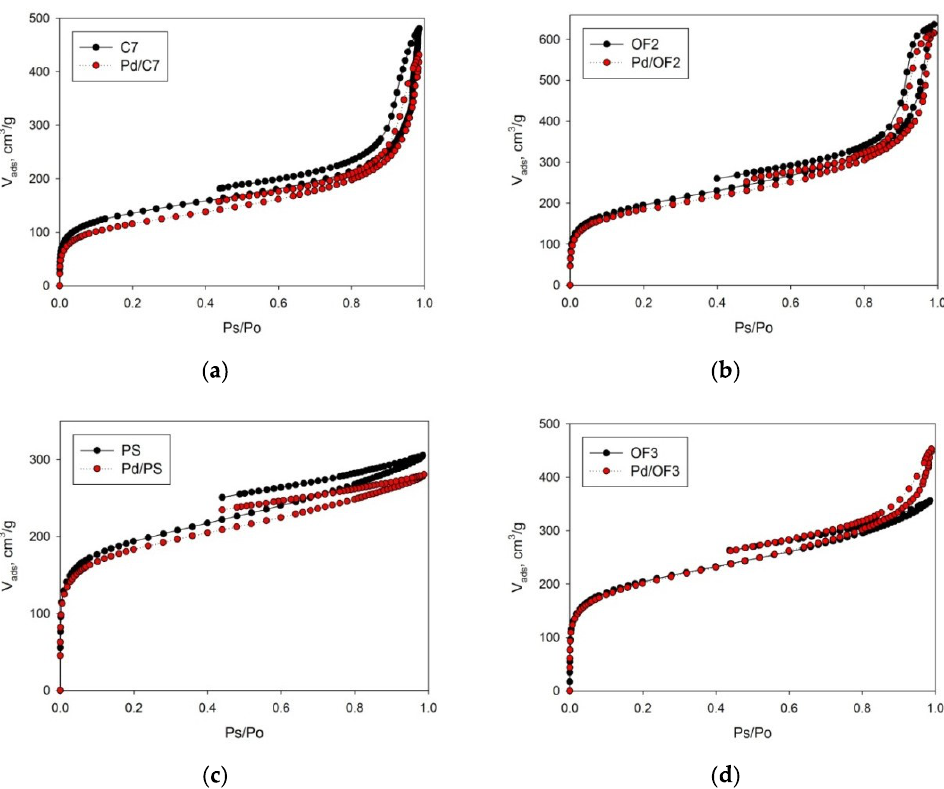
Figure 2. Adsorption–desorption isotherms: ( a ) C7 and Pd/C7; ( b ) OF2 and Pd/OF2; ( c ) PS and Pd/PS; ( d ) OF3 and